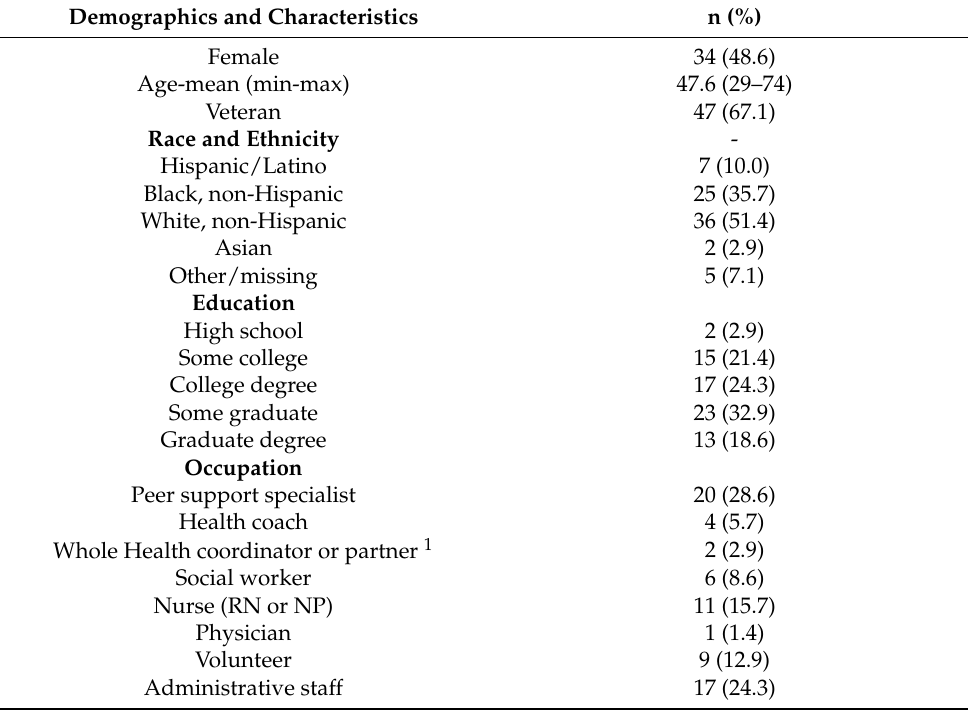
Table 2. Demographics and Characteristics of TCMLH Facilitator Survey Respondents (n = 70).